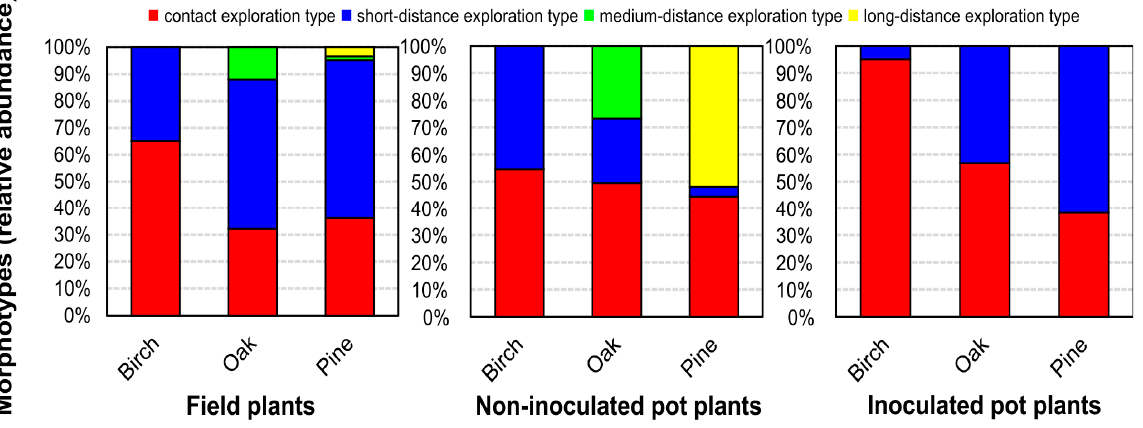
Figure 3. Relative abundance of exploration types of field plants, non-inoculated pot plants, and inoculated pot plants.